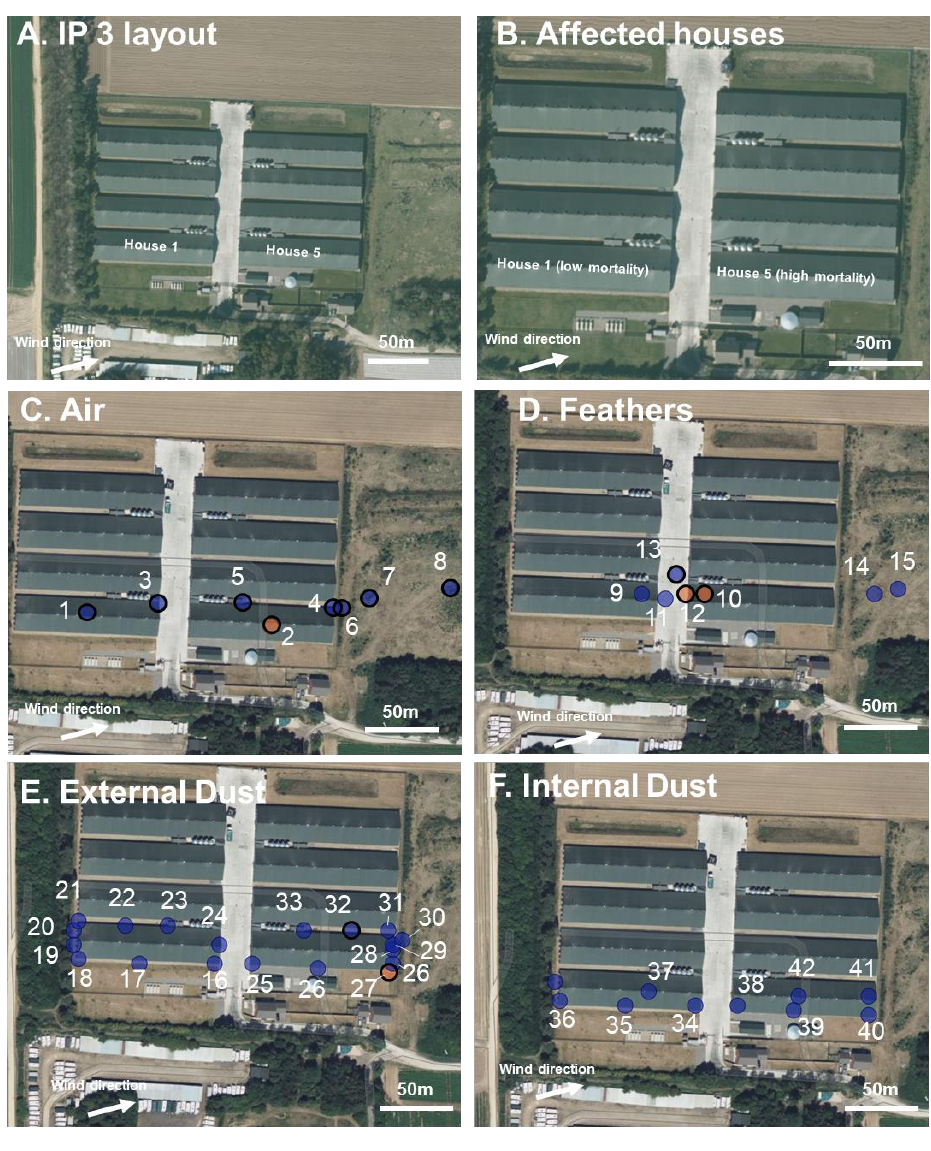
Figure 3. Infected premises 3 (IP3): Environmental sampling and presence or absence of H5 HPAIV RNA at a turkey IP. ( A , B ). Map showing the layout of the IP with the three affected houses indicated, wind direction at time of sampling, and mortality indicated. ( C – F ). The location of the environmental sampling and H5 RRT-PCR results showing the presence (orange) or absence (blue) of H5 HPAIV RNA in the sample and the positive isolation of infectious virus (red outline) or negative isolation of infectious virus (black outline). Samples were collected from air filters ( C ), feathers ( D ), external dust ( E ), and internal dust ( F ). Water and Op and Cl swabs from dead chickens are not shown but indicated in Table